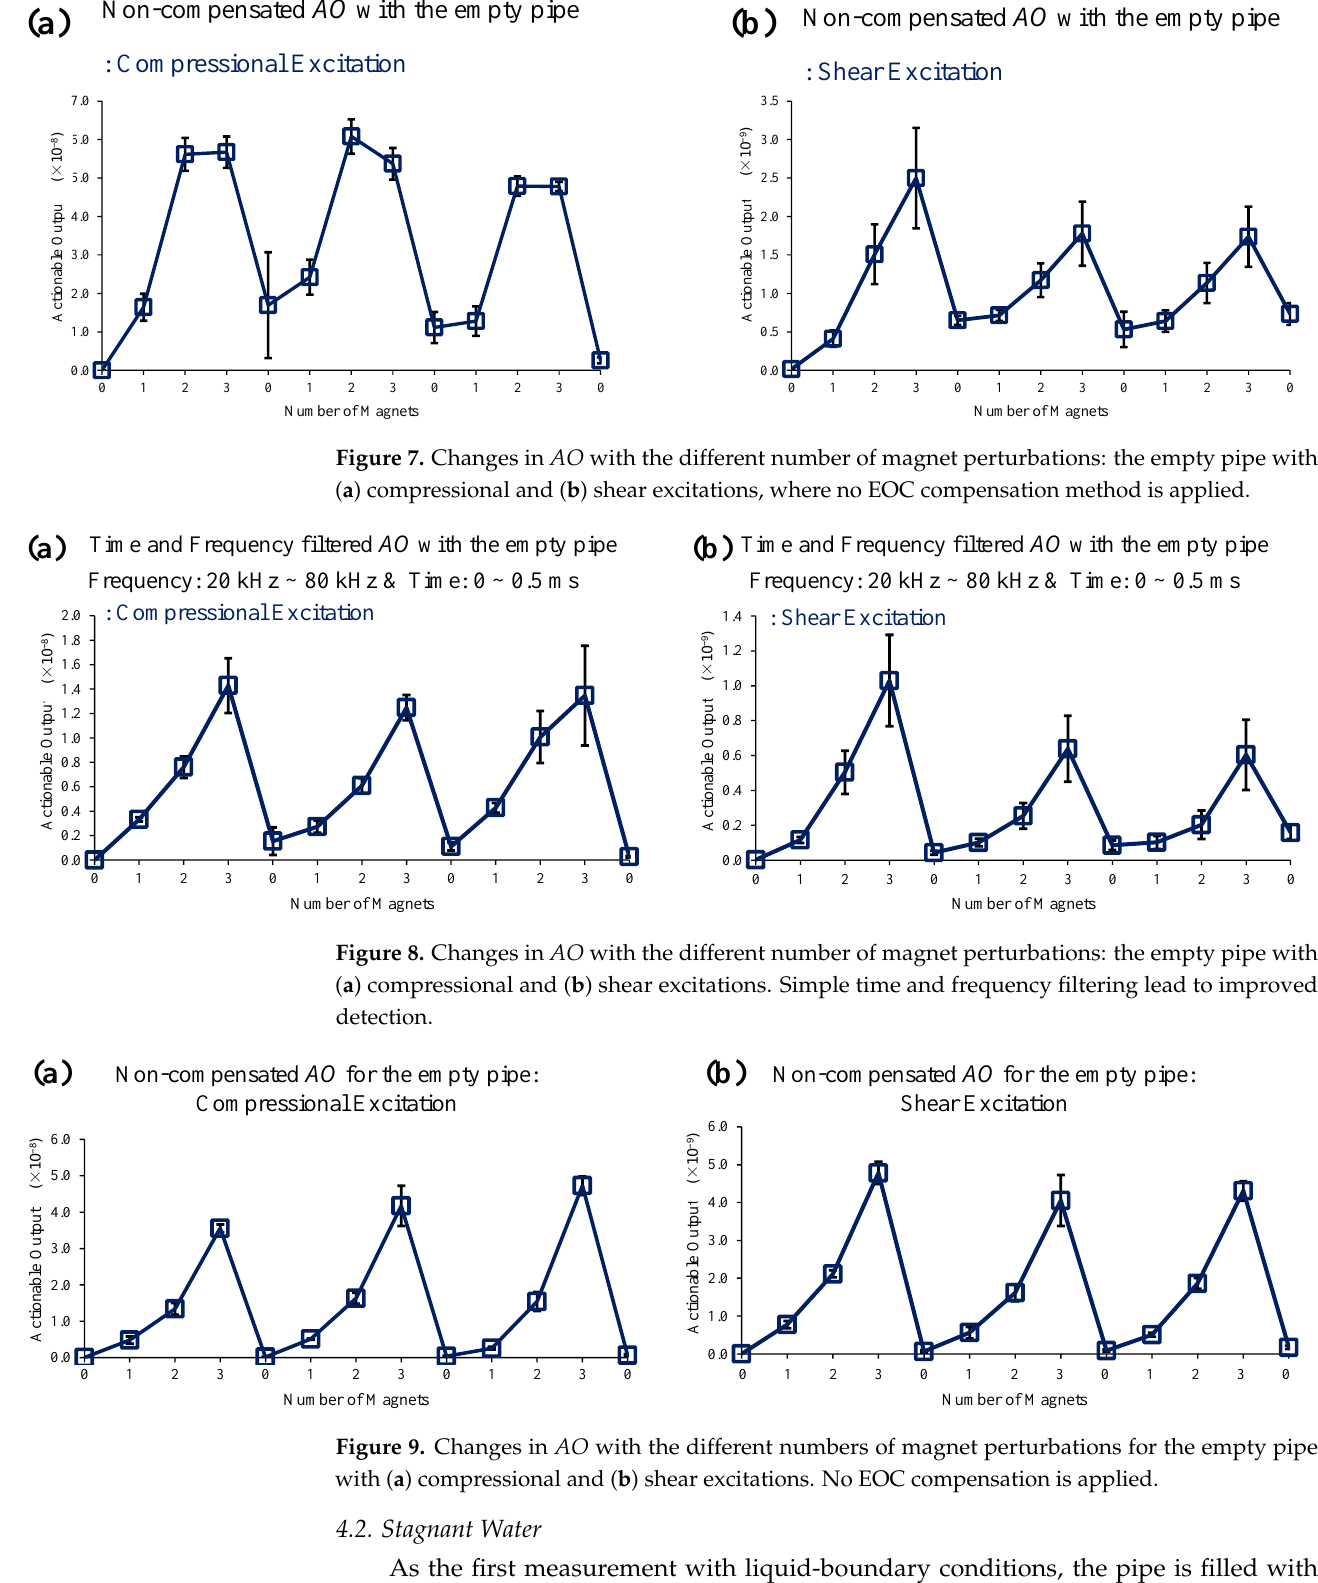
Figure 6. Time domain signals for the empty pipe with compressional ( a ) and shear ( b ) excitations.